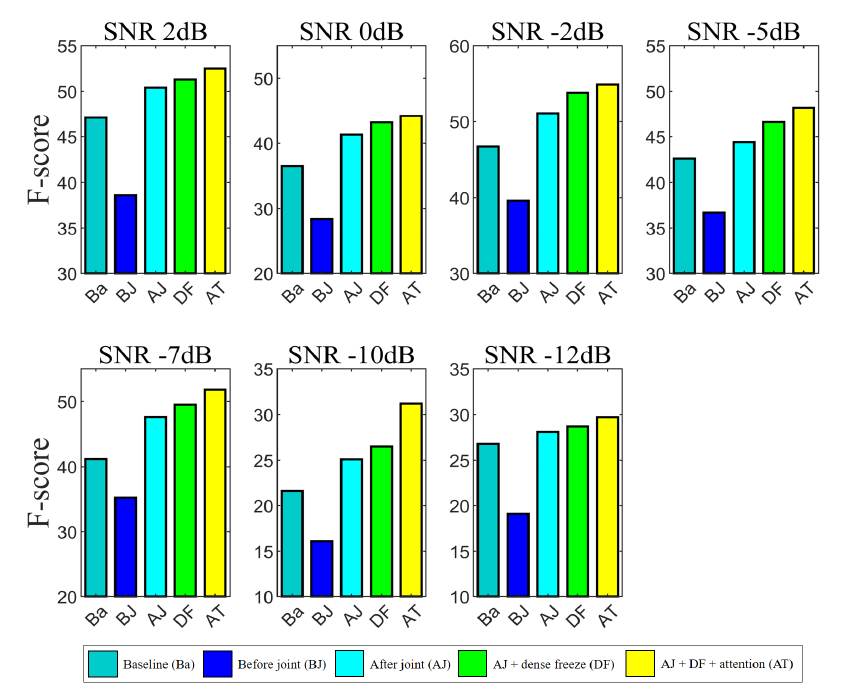
Figure 4. Performance comparison of the test data in different cases based on joint training method